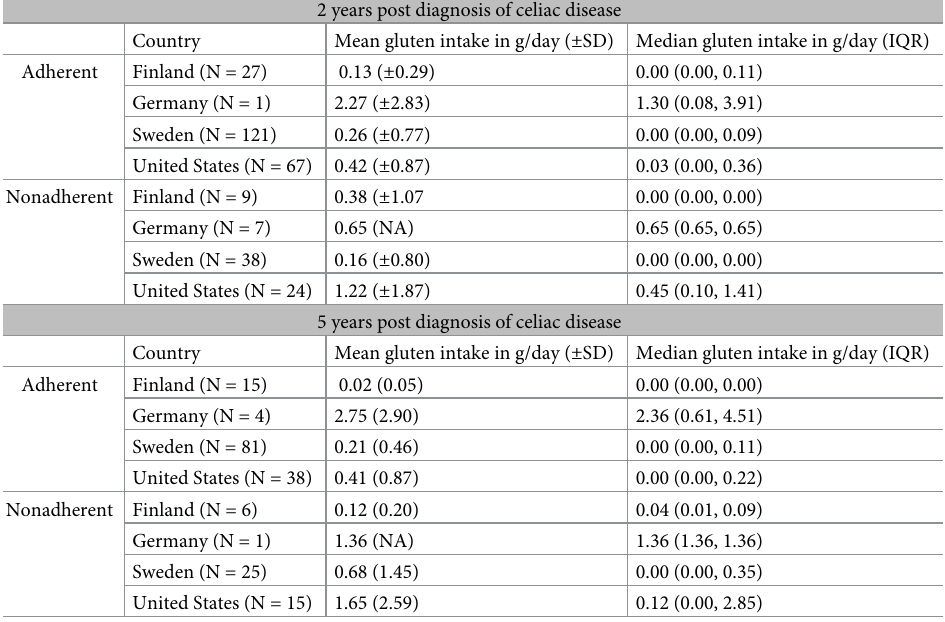
Table 2. Country level gluten-intake. Gluten-intake based on 3-day food records, stratified by country and parent- reported